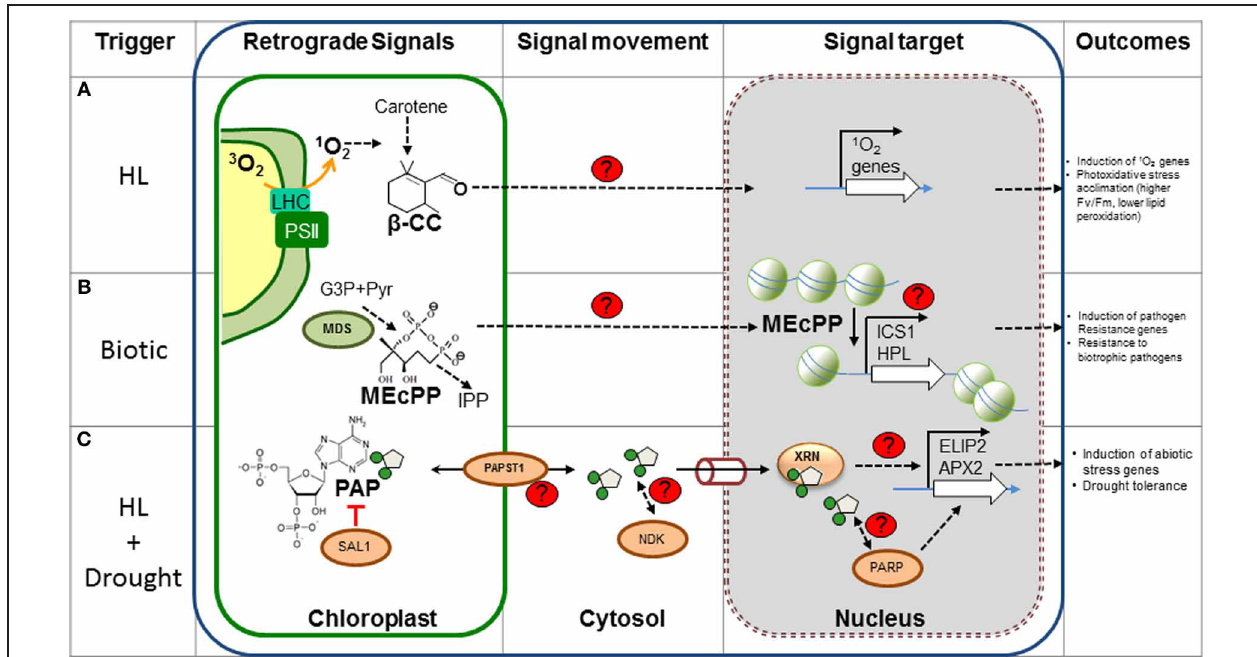
FIGURE 1 | New metabolic retrograde signaling pathways. The different components of recently discovered plant retrograde signaling pathways are shown. (A) β -CC is most likely produced by oxidation of carotenes by 1 O 2 in the chloroplast and could diffuse through the membrane into the cytosol. Feeding β -CC results in the up-regulation of genes involved in stress responses, particularly those triggered by 1 O 2 . It is speculated that the electrophilic carbonyl group could react with electron donors, such as sulfhydryl groups; however, the actual targets and mode of action are unknown. (B) MEcPP, an intermediary of isoprenoid precursors, is produced by MDS in the plastidic MEP pathway. MEcPP over accumulating mutants